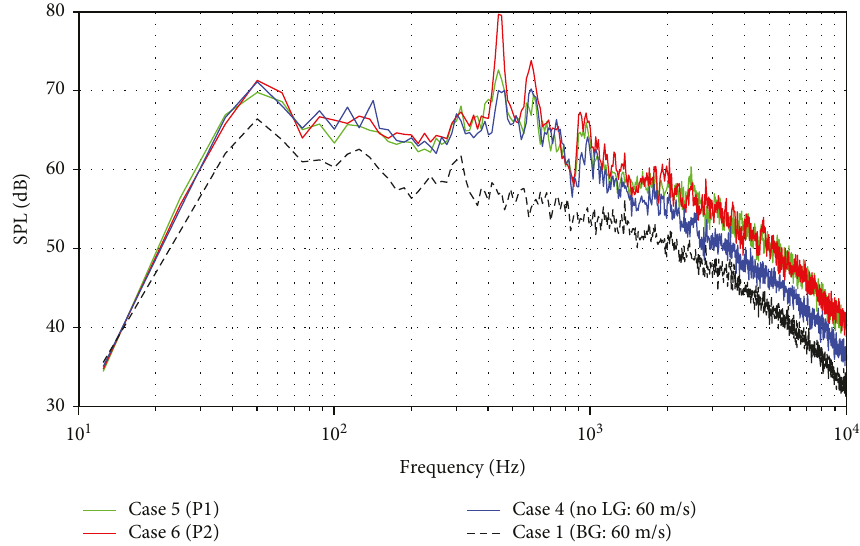
Figure 12: A-weighted spectra for those cases related to the landing gear assembly position.